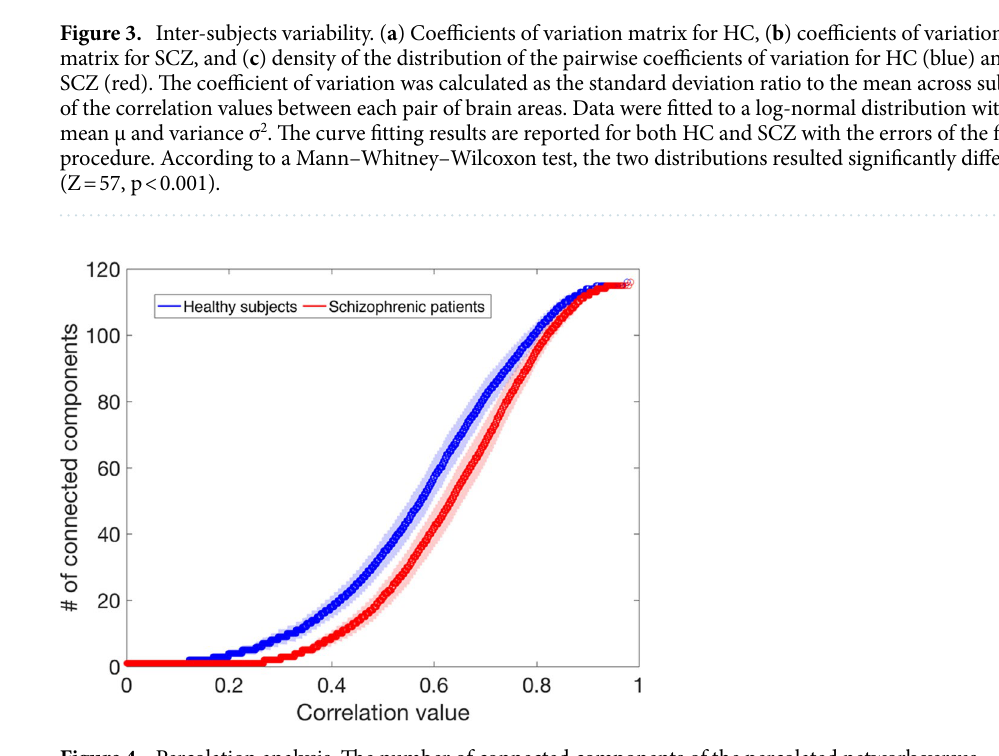
Figure 4. Percolation analysis. The number of connected components of the percolated network versus the related correlation threshold for HC (blue) and SCZ (red). The two curves represent the average of the individual percolation curves and are reported with a 95% confidence